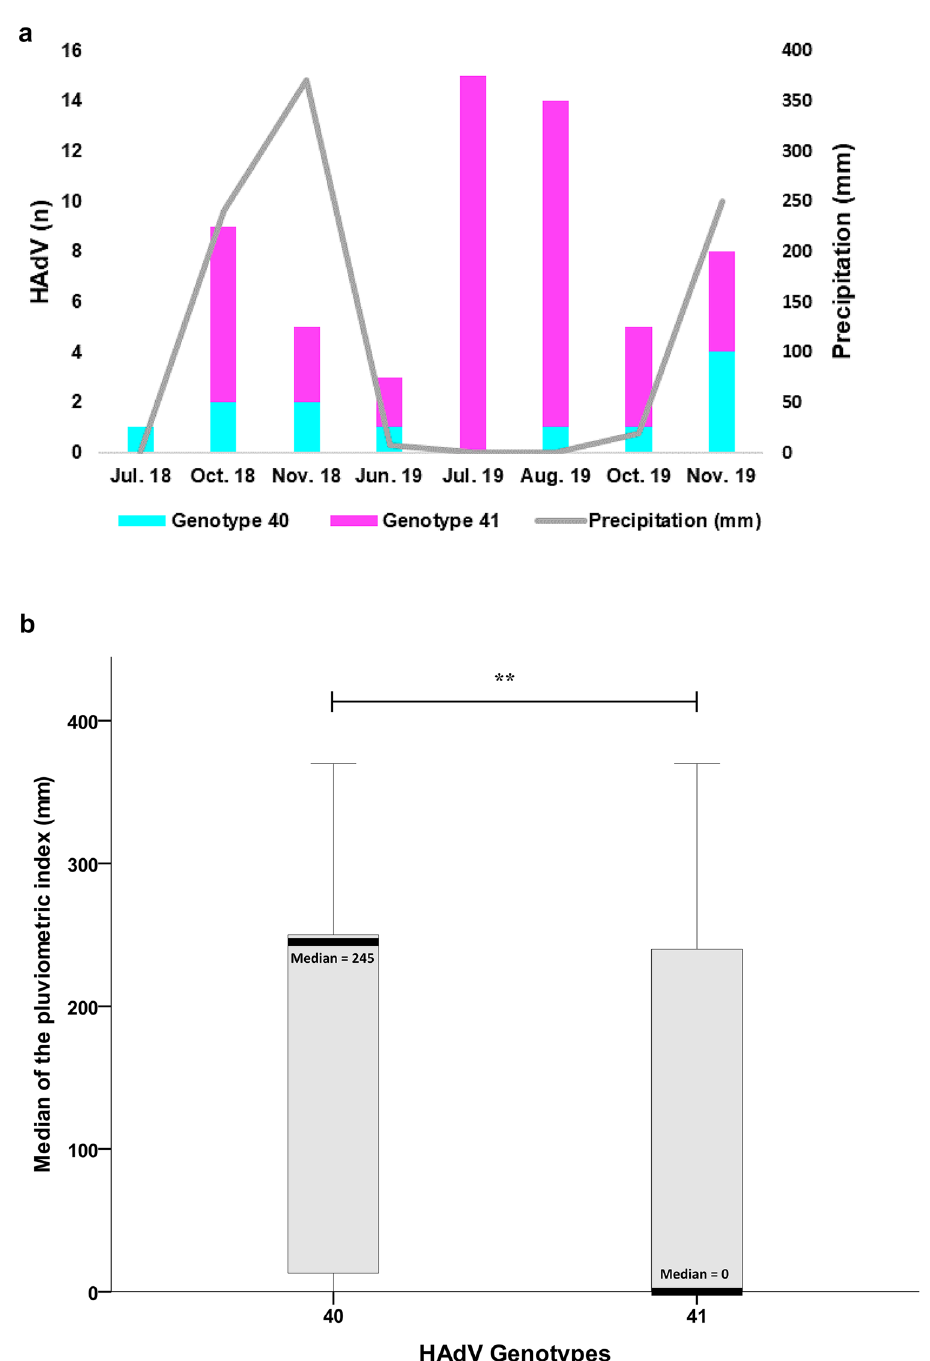
Fig. 3 a Analysis of rainfall, frequency of adenoviruses and occurrence of genotypes 40 and 41 ( r = − 0.098; p > 0.05; s spearman correlation). b Analysis of the rainfall index in relation to HAdV genotypes 40 and 41; (**) p = 0.005;